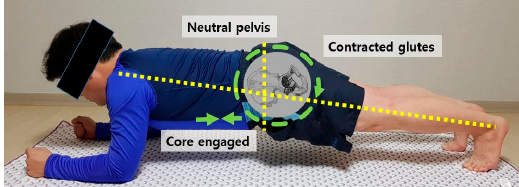
Figure 1. Elbow plank exercise at